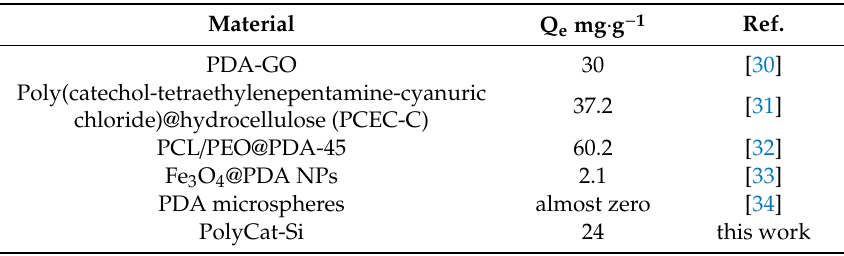
Table 3. Comparison of the adsorption capacity of other adsorbents towards MO in the previous studies at 298 K.